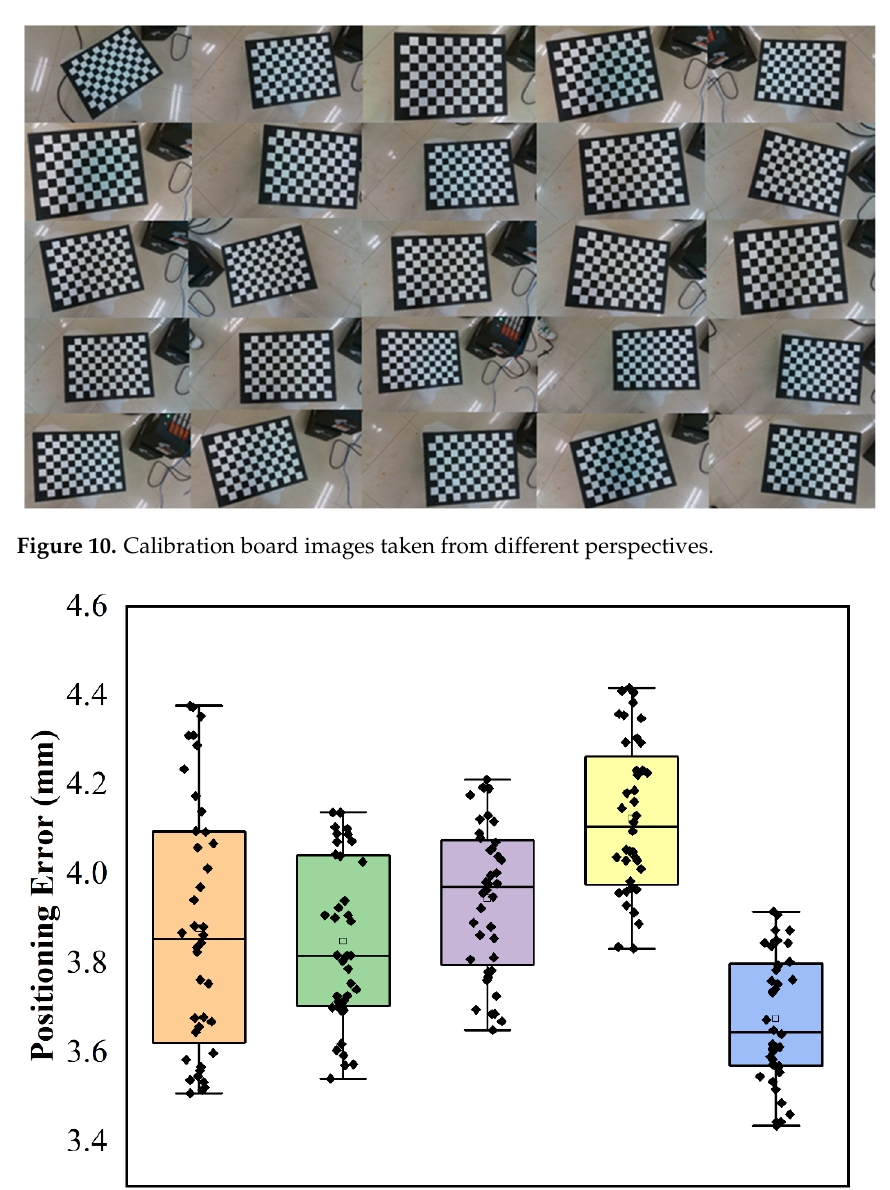
Figure 9. Schematic diagram of hand-eye calibration solution.